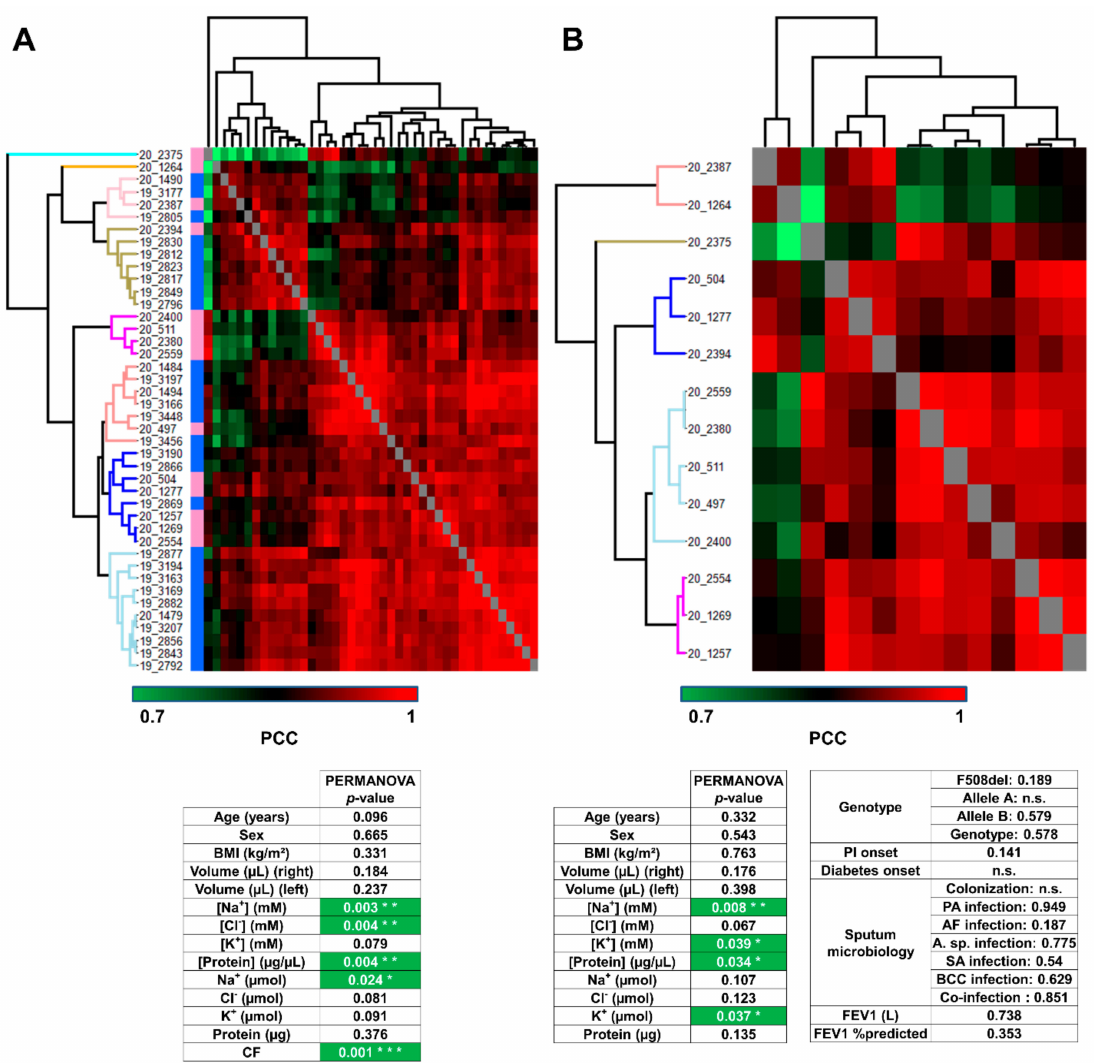
Figure 3. Sweat protein profiles discriminated patients with CF from control subjects, without correlation with CF severity and complications ( A ). Heat-map representation of control versus CF sweat protein profiles. Control samples (blue color bar), CF samples (pink color bar). ( B ) Heat- map representation of CF sweat protein profiles. Hierarchical clustering of Pearson’s correlation coefficients using average Euclidian distance matrix. PERMANOVA test for significance of the correlation between clustering and clinical data distribution (number of permutations = 999, p < 0.05 *, p > 0.01 **, p > 0.001 ***), ion formulae into brackets indicate ion concentrations and ion formulae without brackets indicate ion